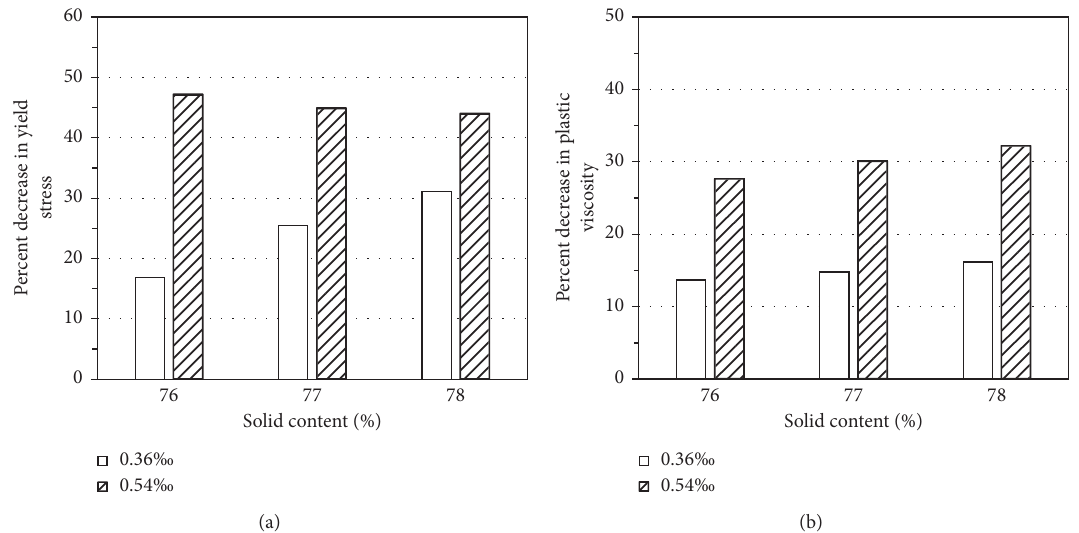
Figure 10: Effects of solid contents and PC dosages on the percentage reduction of (a) yield stress and (b) plastic viscosity of CPB.